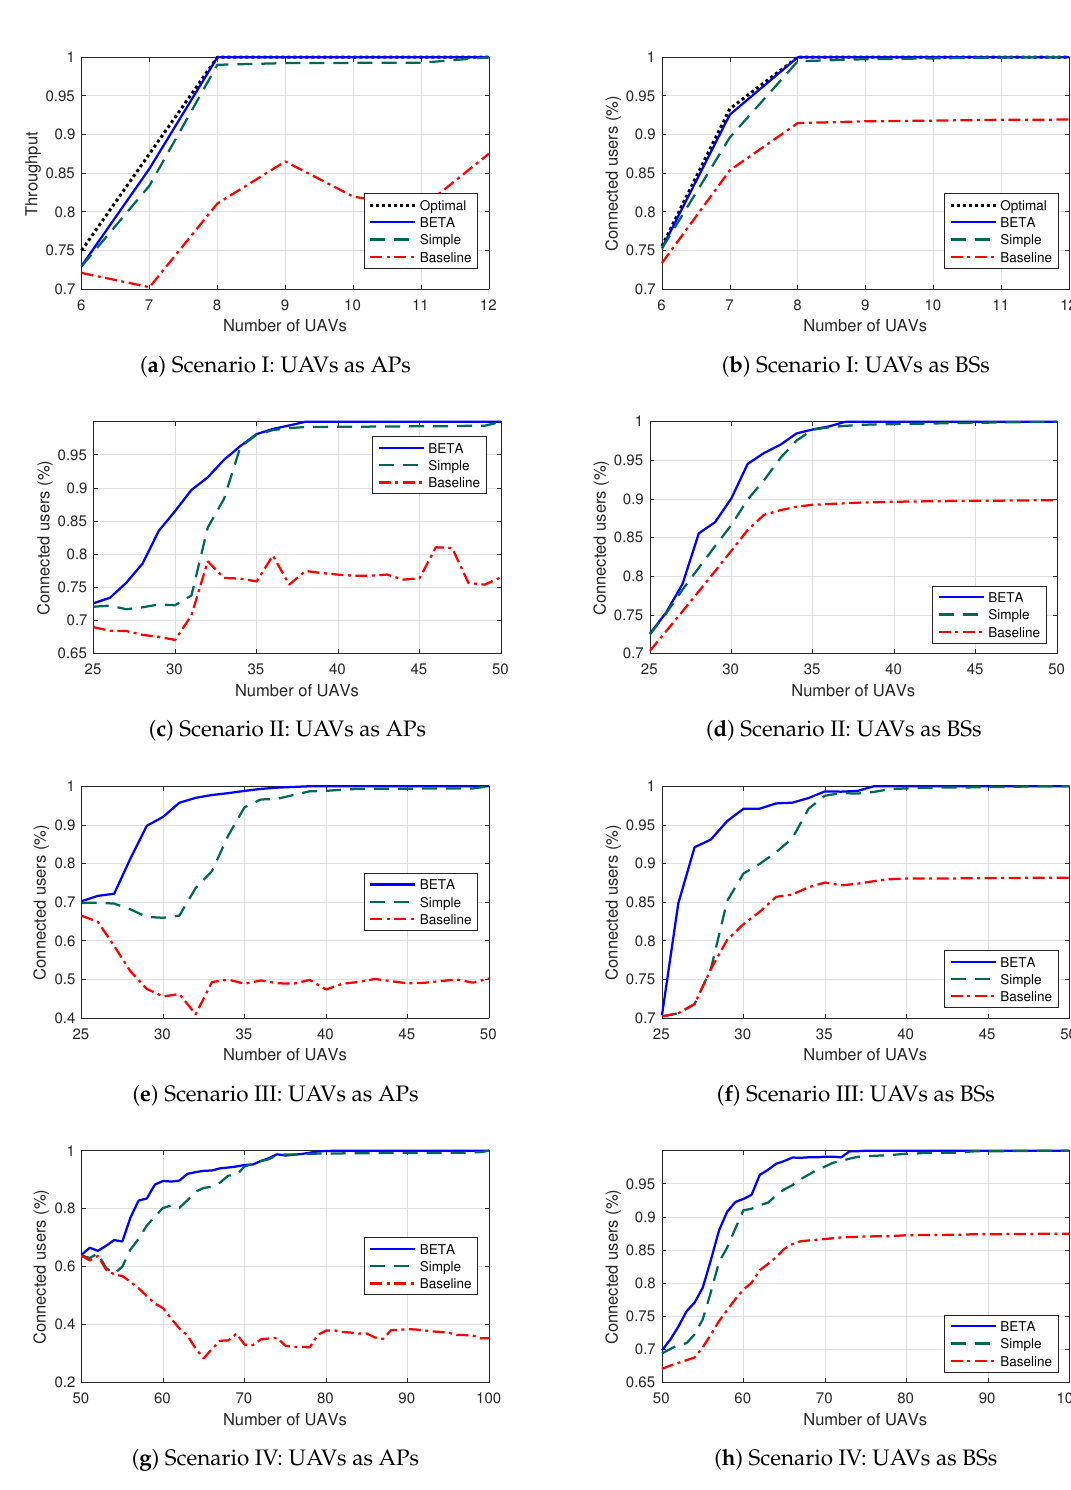
Figure 6. Average number of users connected in different scenarios increasing the fleet